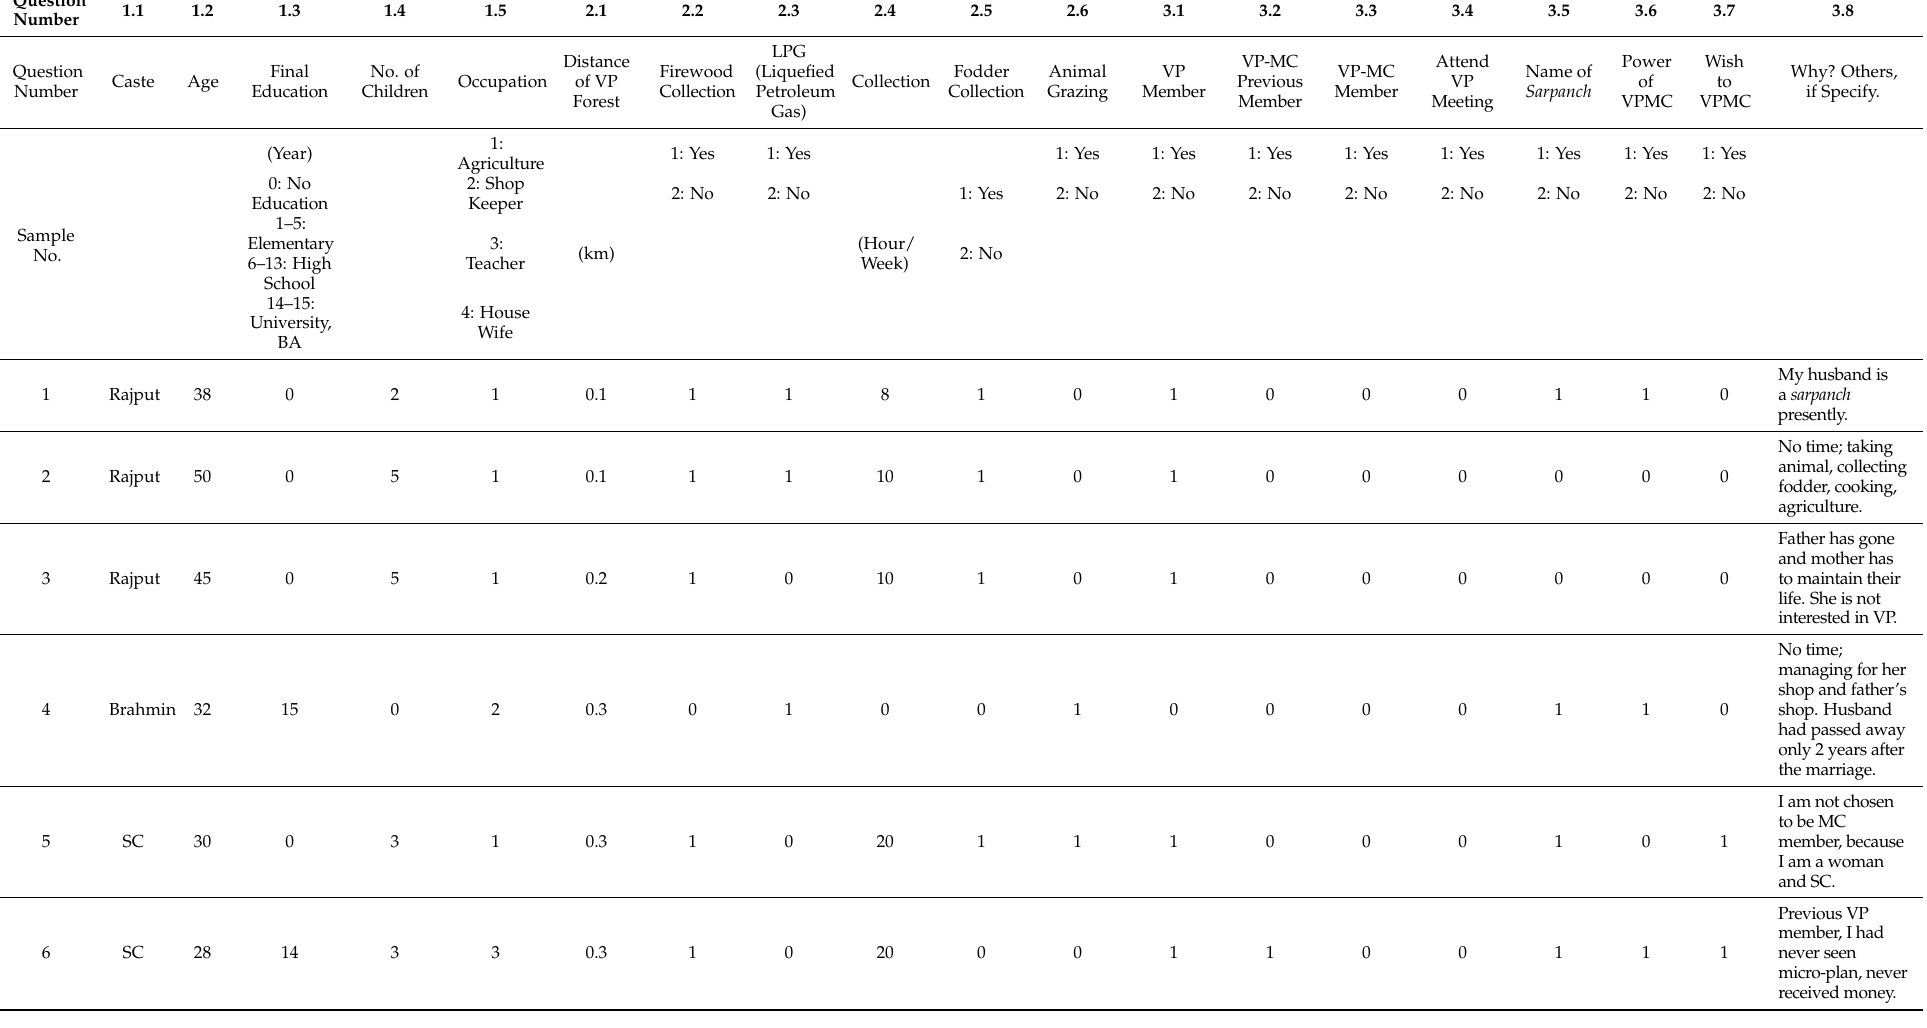
Table 5. The main content of the interviews with the females in D